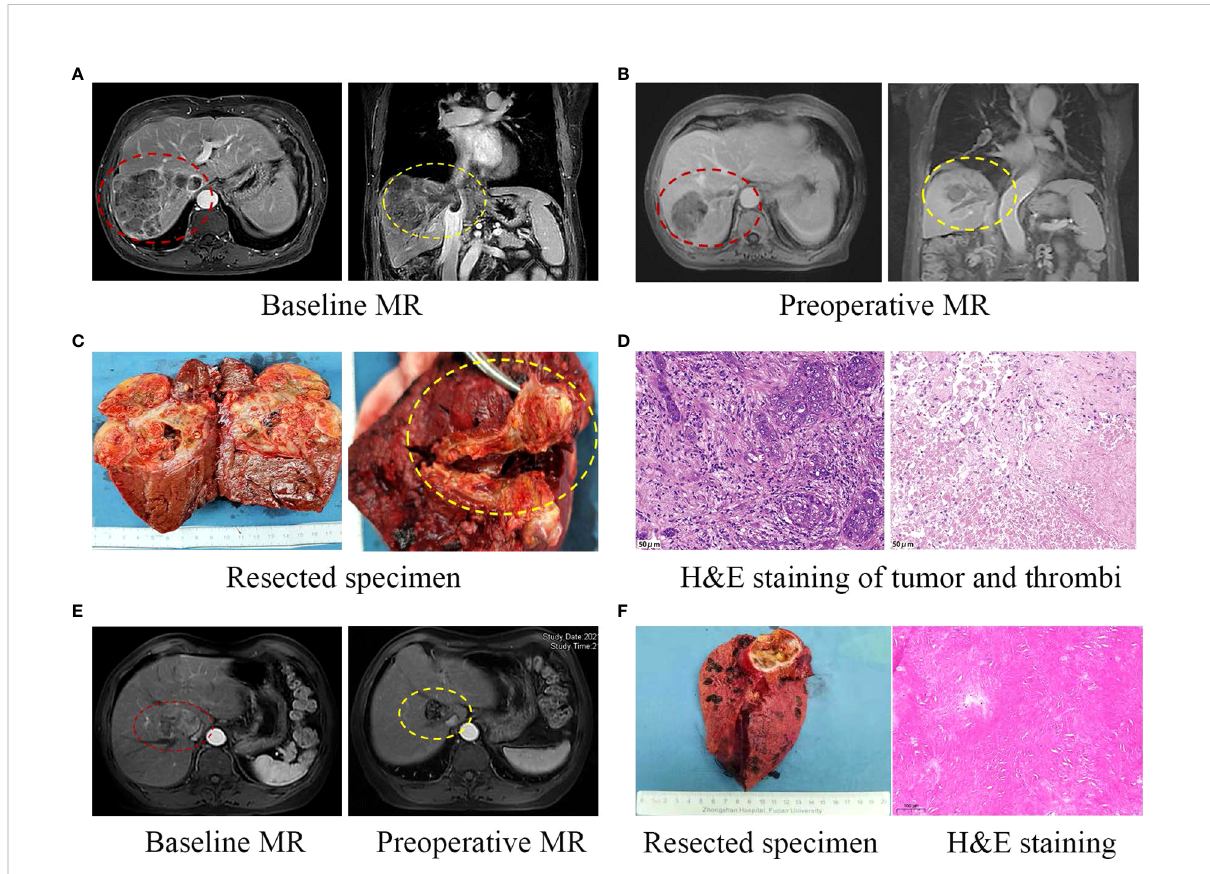
FIGURE 3 Two representative cases. (A) Pre-treatment MR showing both the liver tumor and macrovascular tumor thrombi. (B) Preoperative MR showing the regression of liver tumor and tumor thrombi following systemic therapy. (C) Curative resection of liver tumor and tumor thrombi in right hepatic vein and inferior vena cava. (D) HE staining of surgically resected tumor samples (left) and complete necrosis of the macrovascular tumor thrombi with in fi ltration of in fl ammatory cells (right, 200×). (E) This case was classi fi ed as BCLC stage A, with tumor compression on hepatic vein and inferior vena cava. After the combination therapy, obvious regression of the tumor was observed. The patient underwent curative liver resection and HE staining of resected tumor samples showed massive necrosis without viable tumor cells (F)